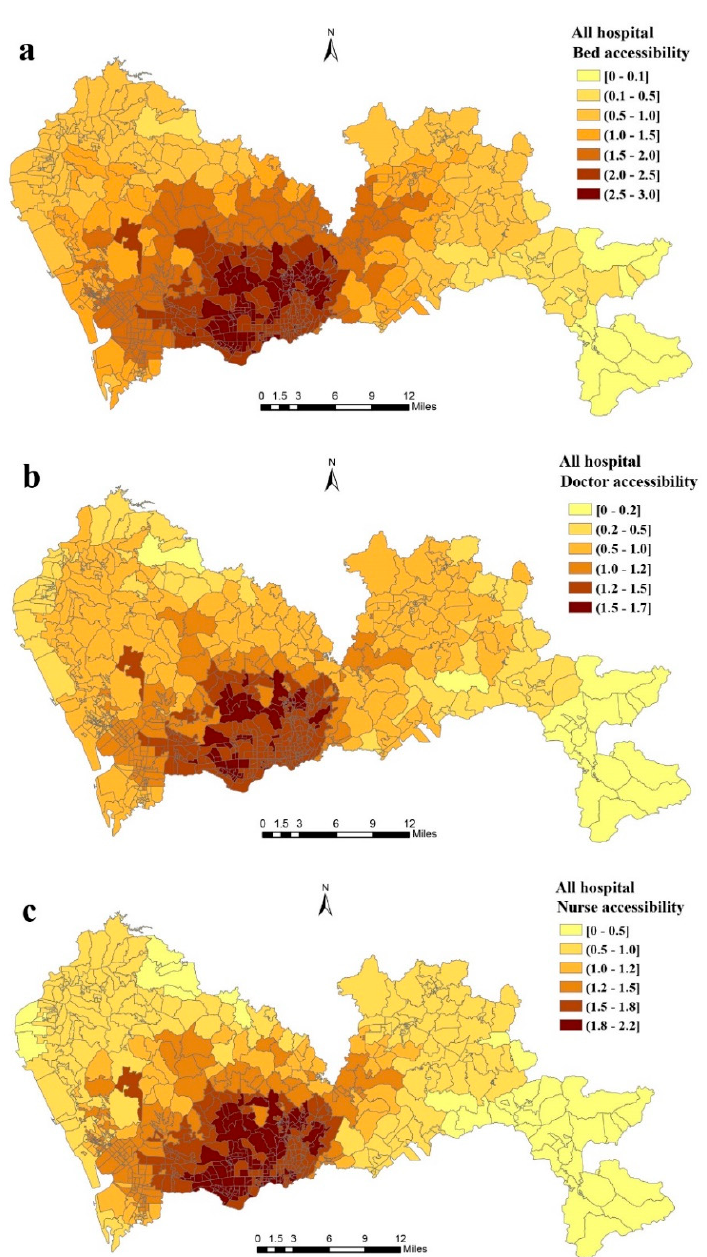
Figure 4. Spatial accessibility of ( a ) beds, ( b ) doctors, and ( c ) nurses in general hospitals in Shenzhen calculated using the enhanced two-step floating catchment area (E2SFCA) method.